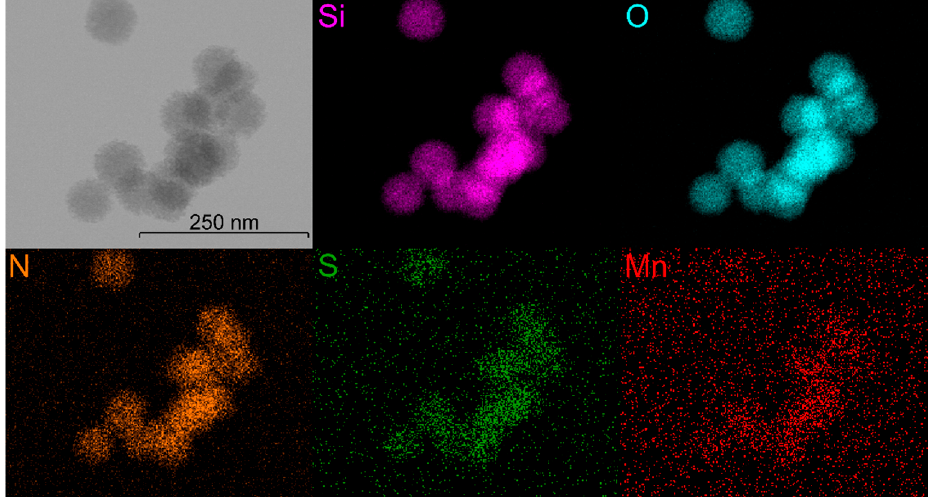
Figure 4. STEM-EDS images of MSN-4b with topochemical distribution of Si (pink), O (cyan), N (orange), S (green) and Mn (Red).